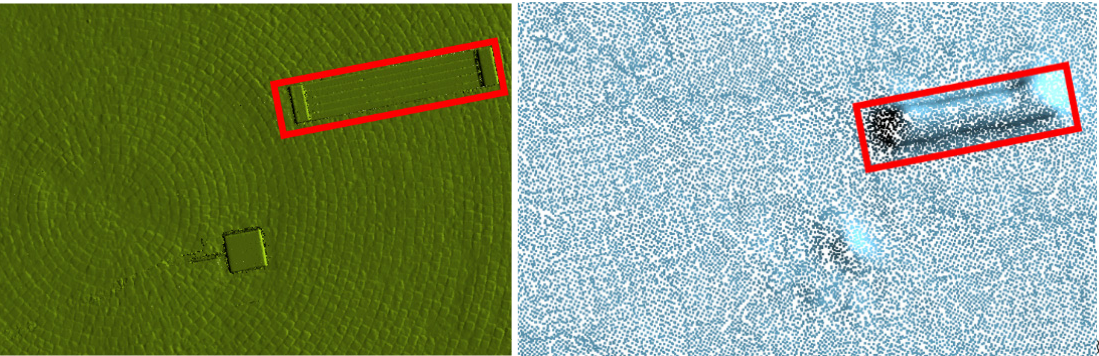
Figure 13. Reference data from terrestrial laser scanning (left), dense point cloud from PS TIF (right)